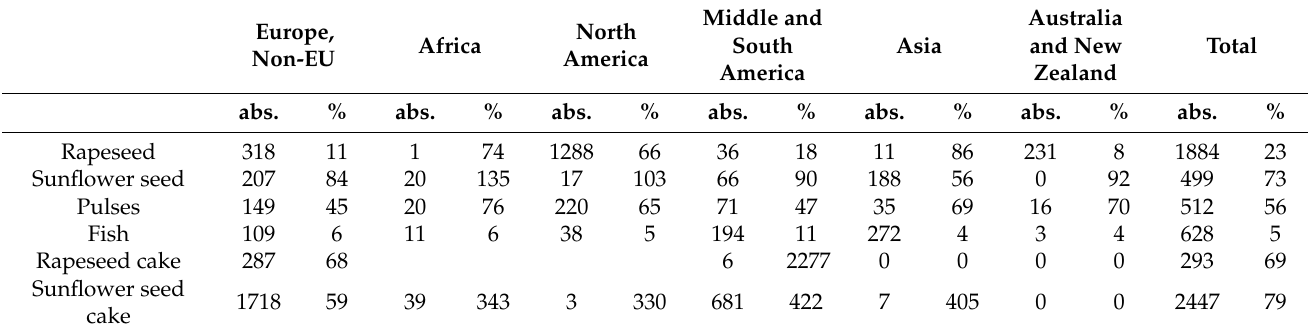
Table 5. Absolute and percentage changes of EU imports by